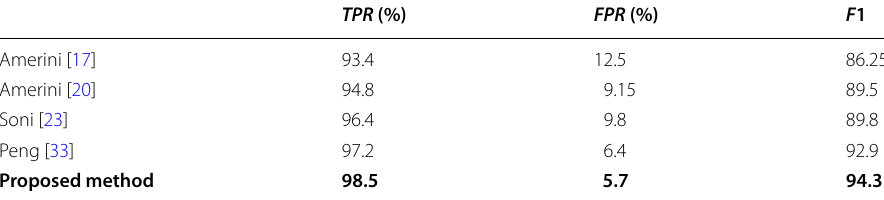
Bold font indicates that the current method has the highest